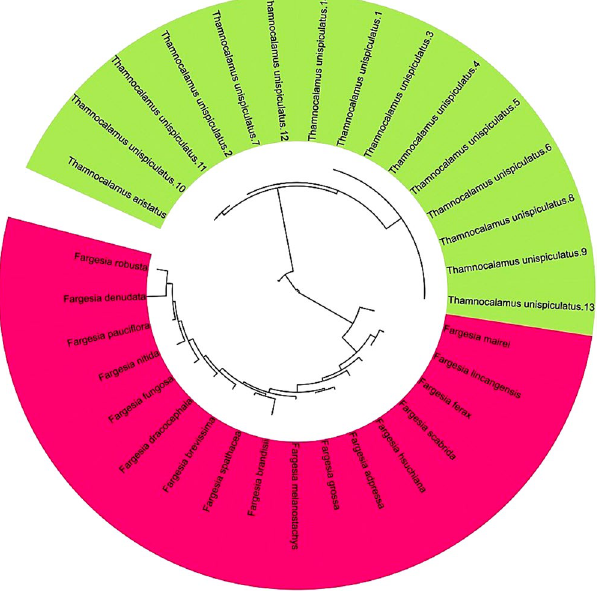
Figure 3. Unrooted dendrogram representing relationships among Fargesia and Thamnocalamus species estimated with a SOM neural network. For all characters, the mean value was used to construct the dendrogram. Tree distances were calculated with the SOM Neural Network Toolbox for MATLAB software (MathWorks Inc., Natick, MA, USA) and the online tool Interactive Tree Of Life (ITOL;